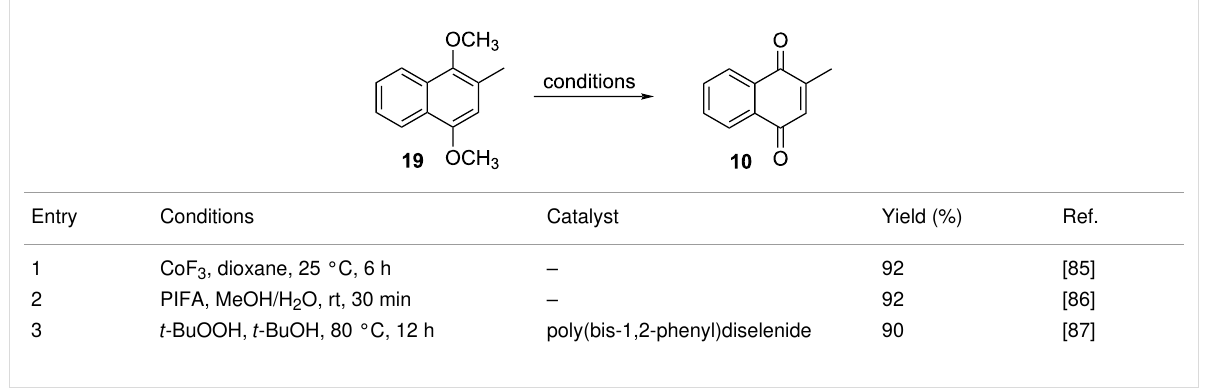
Table 3: Different approaches of 2-methyl-1,4-dimethoxynaphthalene oxidation to